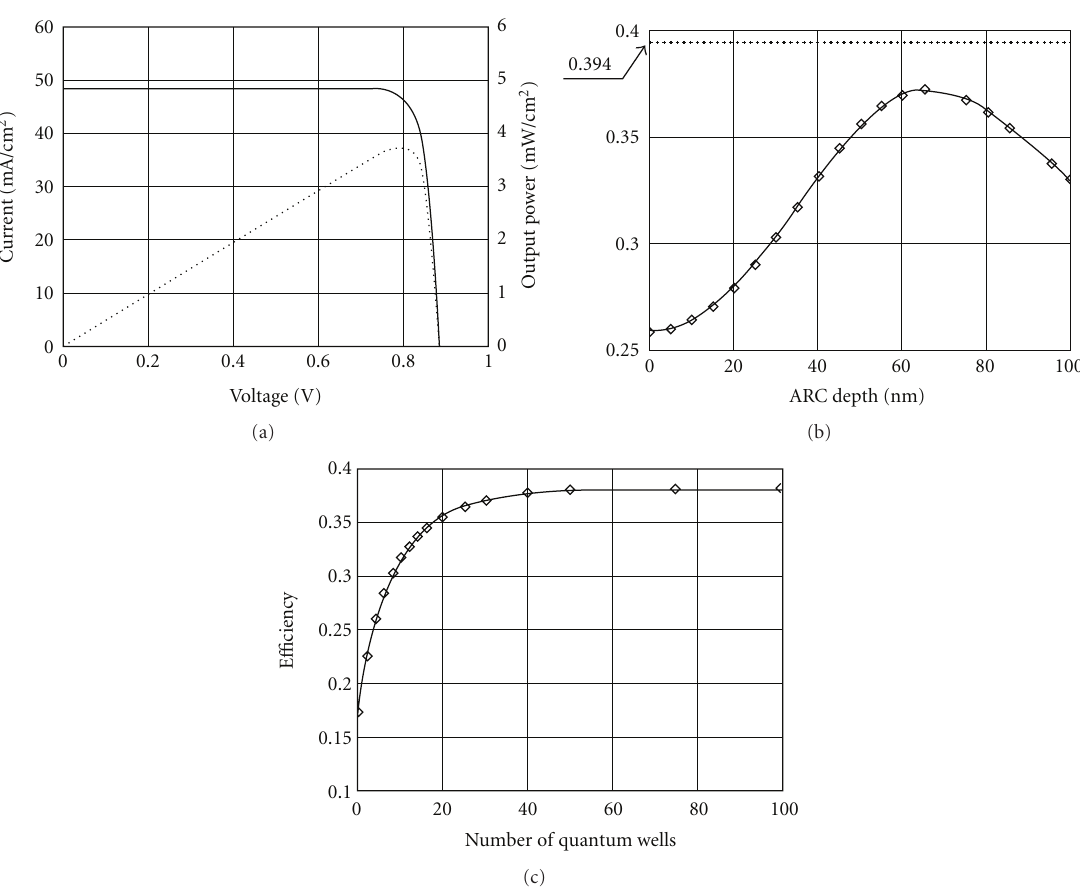
Figure 9: (a) Voltage-current characteristic (line) and the output power (points) of the cell with the following MQW system: GaAs/Al 0 . 3 Ga 0 . 7 As, N w = 30, l w = 20nm, l b = 10nm and the antireflecting coating depth d = 64nm. (b) The MQW cell e ffi ciency depending on the antireflecting coating depth. The dotted line indicates the ideal cell e ffi ciency with zero reflectance. (c) The e ffi ciency of MQW cell based on the number of quantum